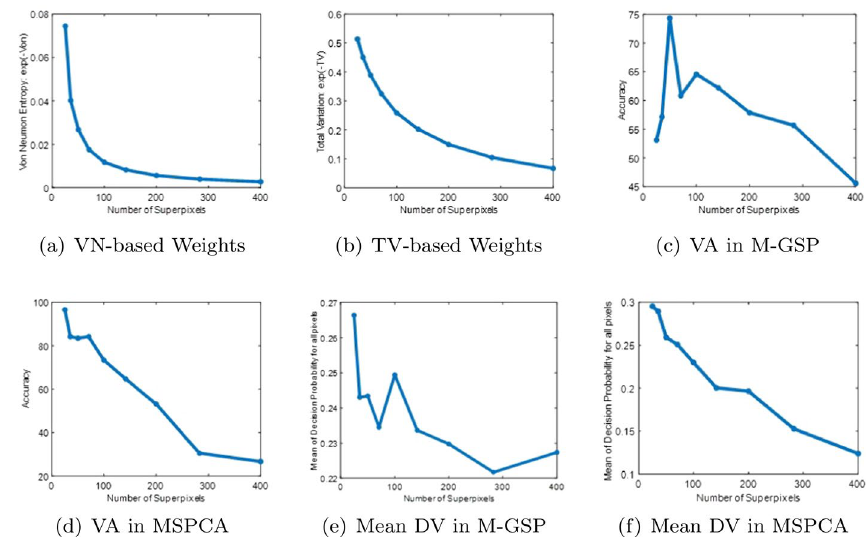
Fig. 16 Decision strengths over different numbers of